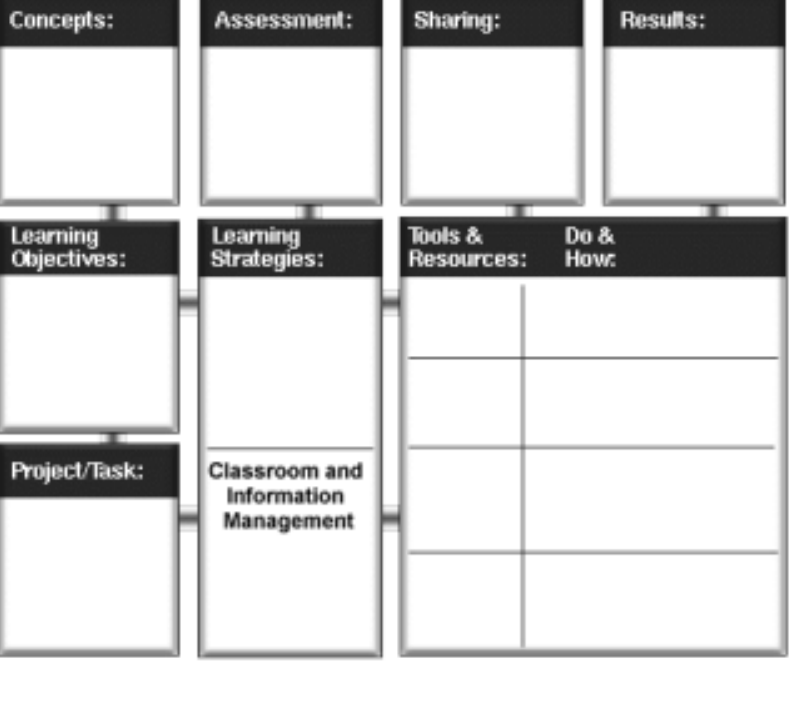
International Review of Research in Open and Distance